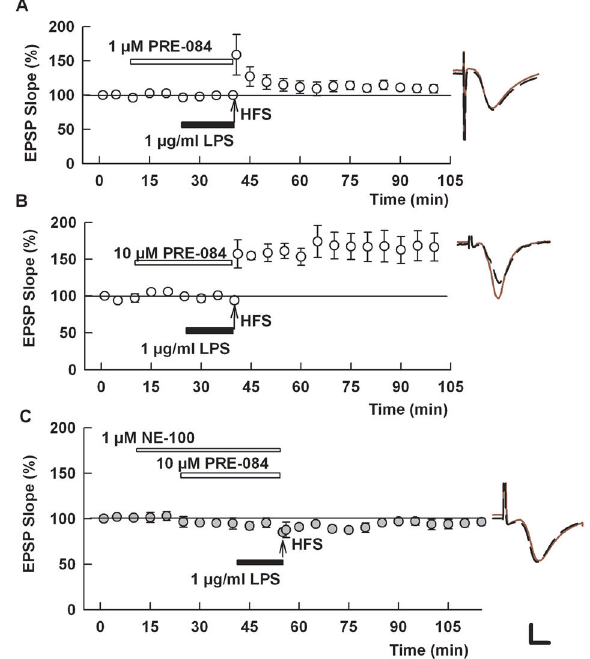
Fig. 2 A selective S1R agonist overcomes the effects of LPS on LTP. A , B At 1 μ M, PRE-084 had weak effects on LPS-mediated LTP block ( A ), but 10 μ M PRE-084 completely overcame the effects of LPS ( B ). C The effects of PRE-084 were blocked by N-100, an S1R antagonist [36]. Traces show representative EPSPs. Calibration: 1 mV, 5 ms. (5AR) inhibitor, fi nasteride. In prior studies, we found that 1 μ M fi nasteride blocks stressor-induced immunostaining for 5 α -